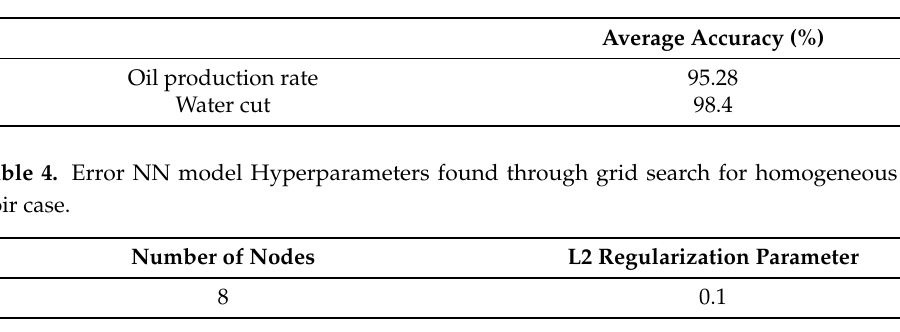
Figure 26. Error in the prediction of ( a ) the oil production rate and ( b ) water cut for all the test cases before and after the error correction of the solutions. Table 3. Homogeneous reservoir case 1: the average accuracy of the oil production rate and water cut for all test samples.